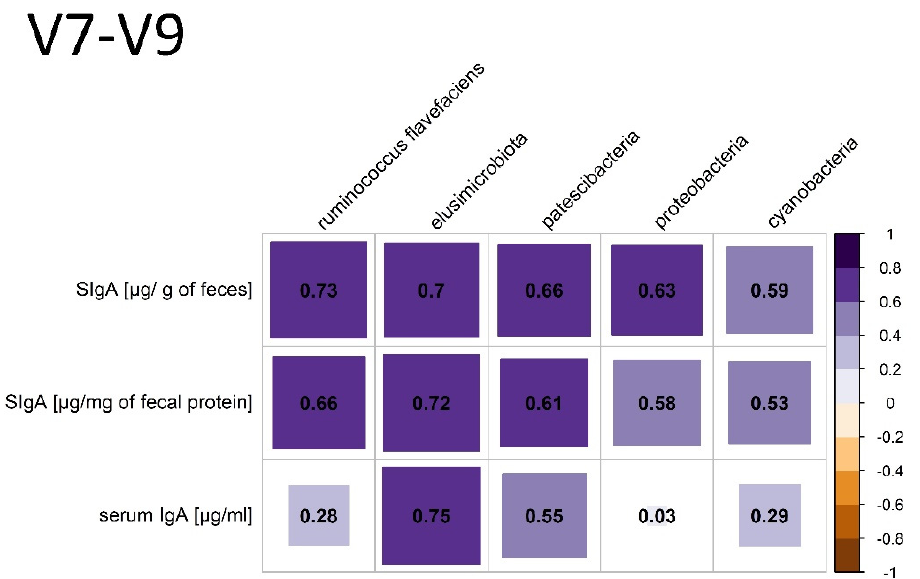
Figure 4. Relative abundance of microbiota from horse feces at the phylum level. Taxonomy based on V7–V9 hypervariable region of 16S rRNA gene. Phyla whose relative abundance accounts for less than 0.01 are found in Others.